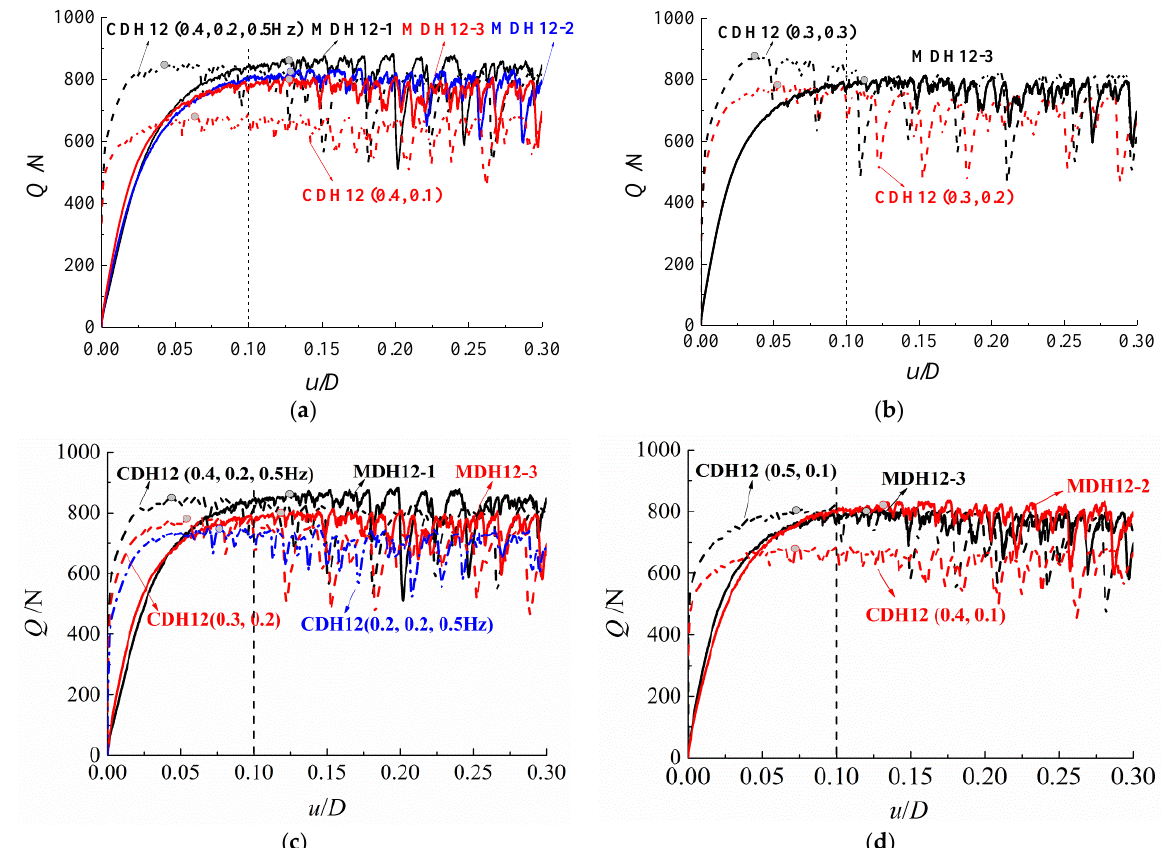
Figure 14. Monotonic and post-cyclic monotonic responses for different amplitudes and mean cyclic loads: ( a ) Q mean / Q t = 0.4; ( b ) Q mean / Q t = 0.3; ( c ) Q cyc / Q t = 0.2; ( d ) Q cyc / Q t = 0.1.